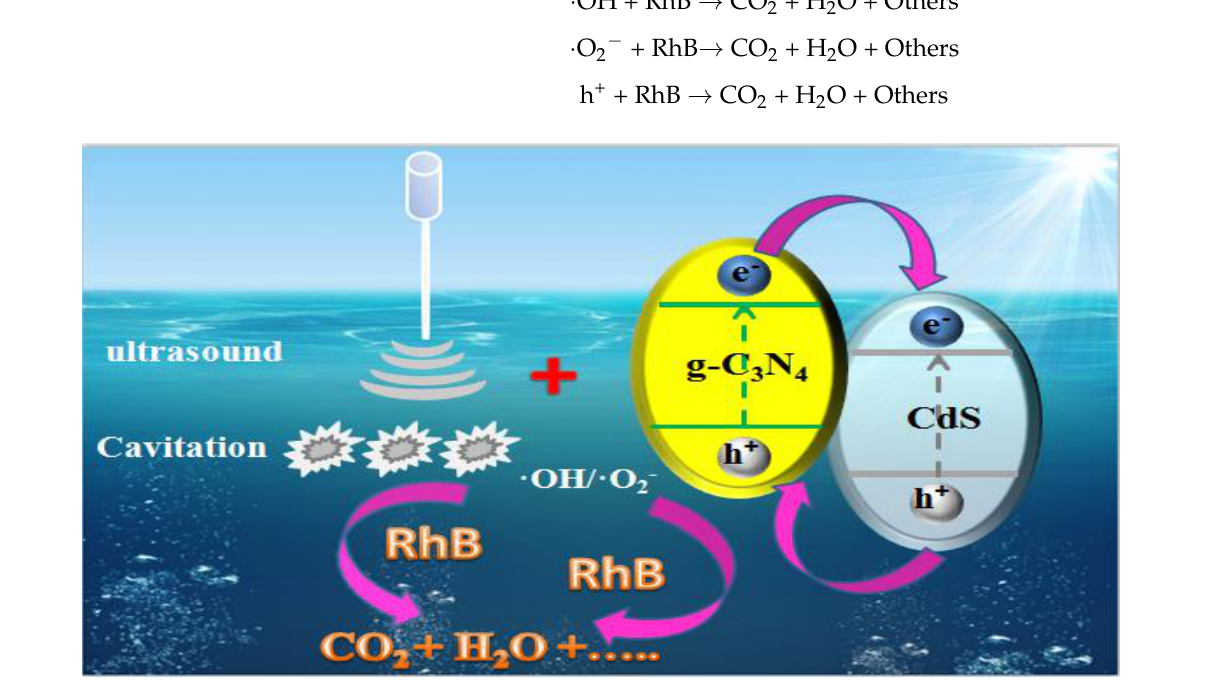
Figure 8. Proposed sono-photocatalytic mechanism for degradation of RhB with PAN/g-C 3 N 4 /CdS heterojunction.